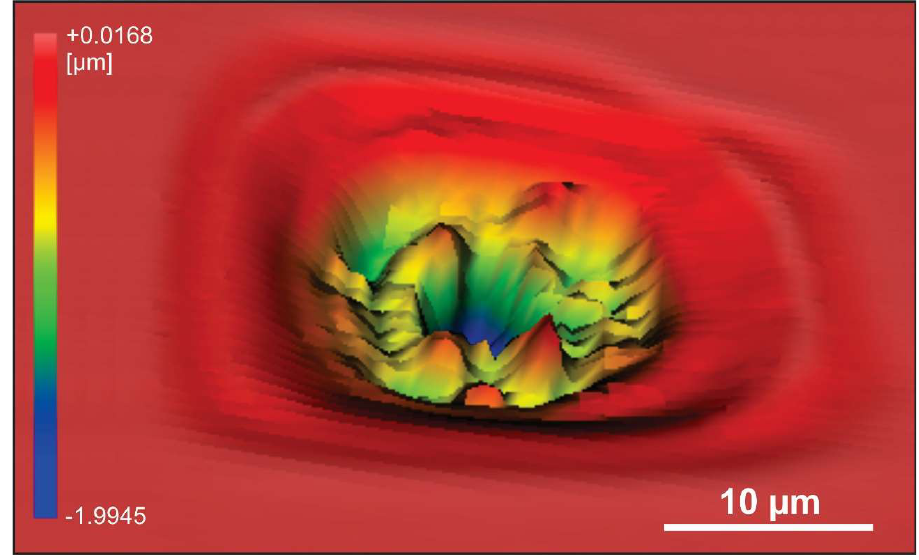
Figure 5. 3D surface topographic map of a sputtering crater created by the described Secondary Ion Mass Spectrometry (SIMS) experiment conditions in hydrothermal quartz of the Berglia-Glassberget breccia.